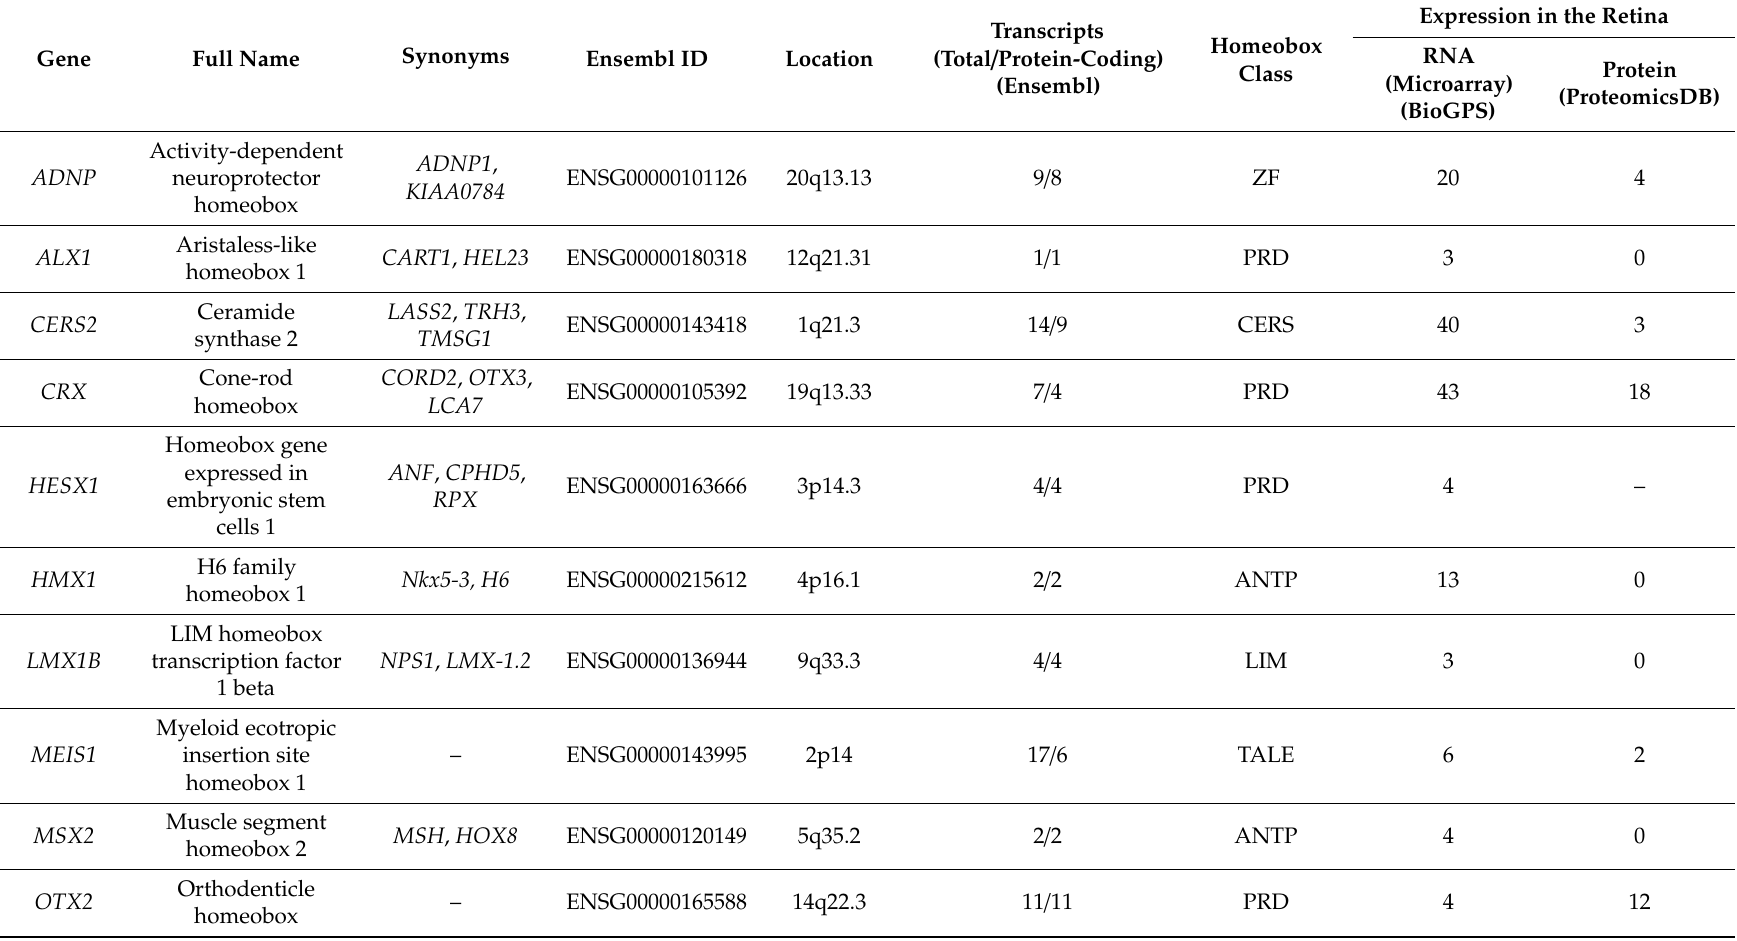
Table 1. Properties of human homeobox genes associated with inherited retinal diseases (IRDs) and secondary retinal